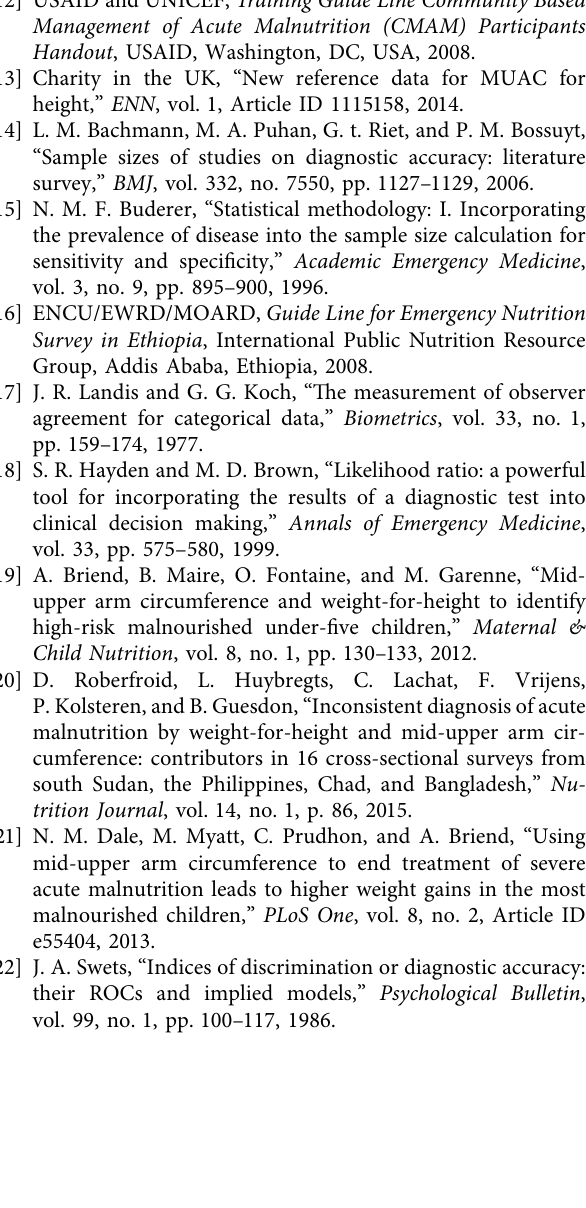
Table S1: diagnostic test characteristics and their